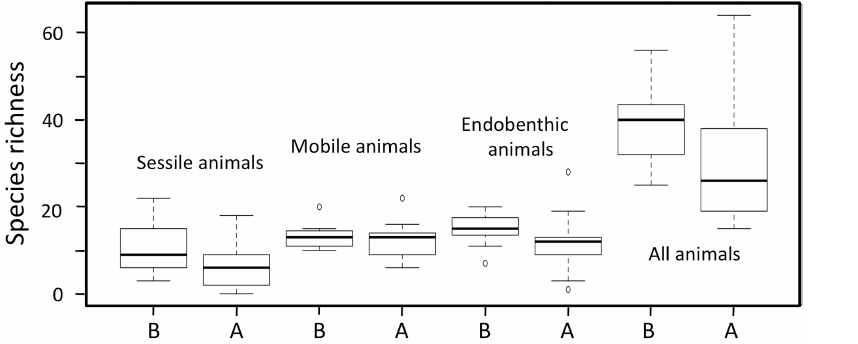
Figure 2. Box plots showing taxon richness of sessile epibenthic animals, mobile epibenthic animals, endobenthic animals and all animals before (B) and just after the tsunami